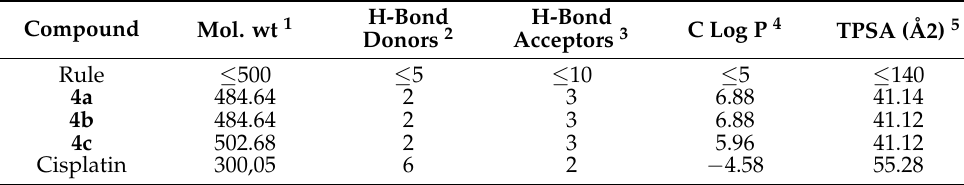
Table 1. Physicochemical properties of the synthesized compounds. Compound Mol. wt 1